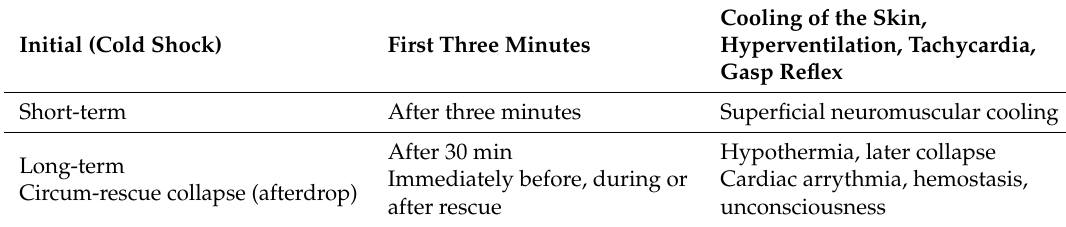
Table 2. Three stages of immersion in cold